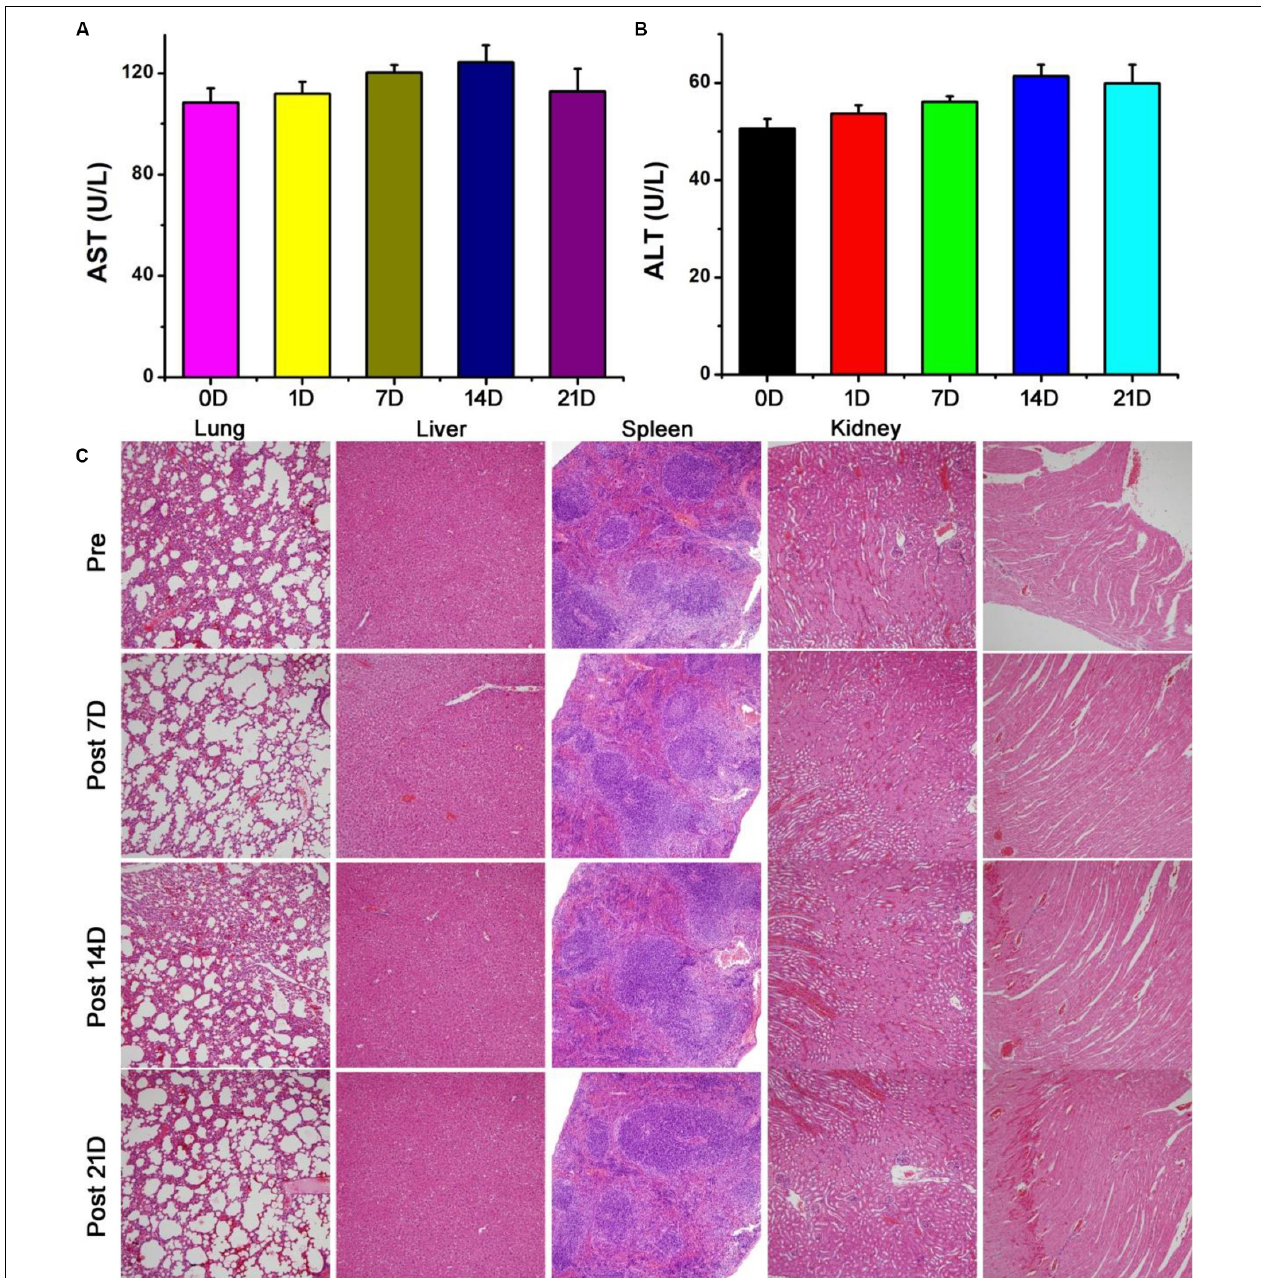
FIGURE 7 | Blood biochemical results of control group and Bi 2 S 3 nanorod at different time points (1, 7, 14, 21 days) after injection: (A) aspartate aminotransferase (AST), (B) alanine aminotransferase (ALT). (C) HE analysis of main organs at different time points (0, 7, 14, 21 days) after injection, including lung, liver, spleen, kidney and heart. Magnification: 100